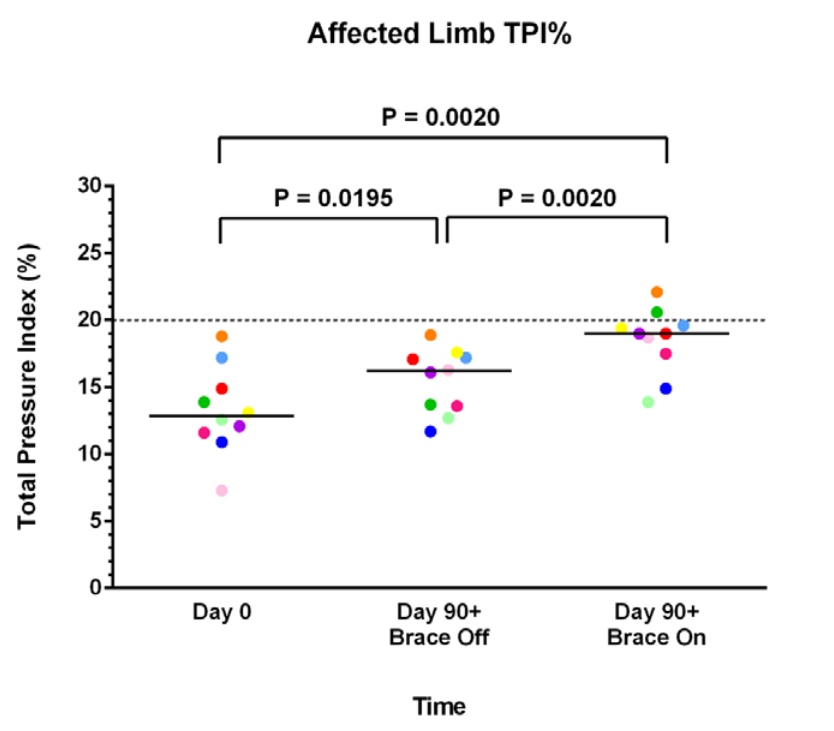
Figure 2: Affected Limb